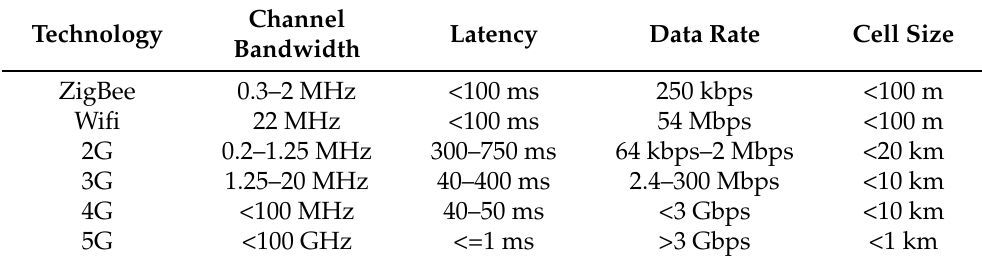
Table 1. Wireless/Cellular